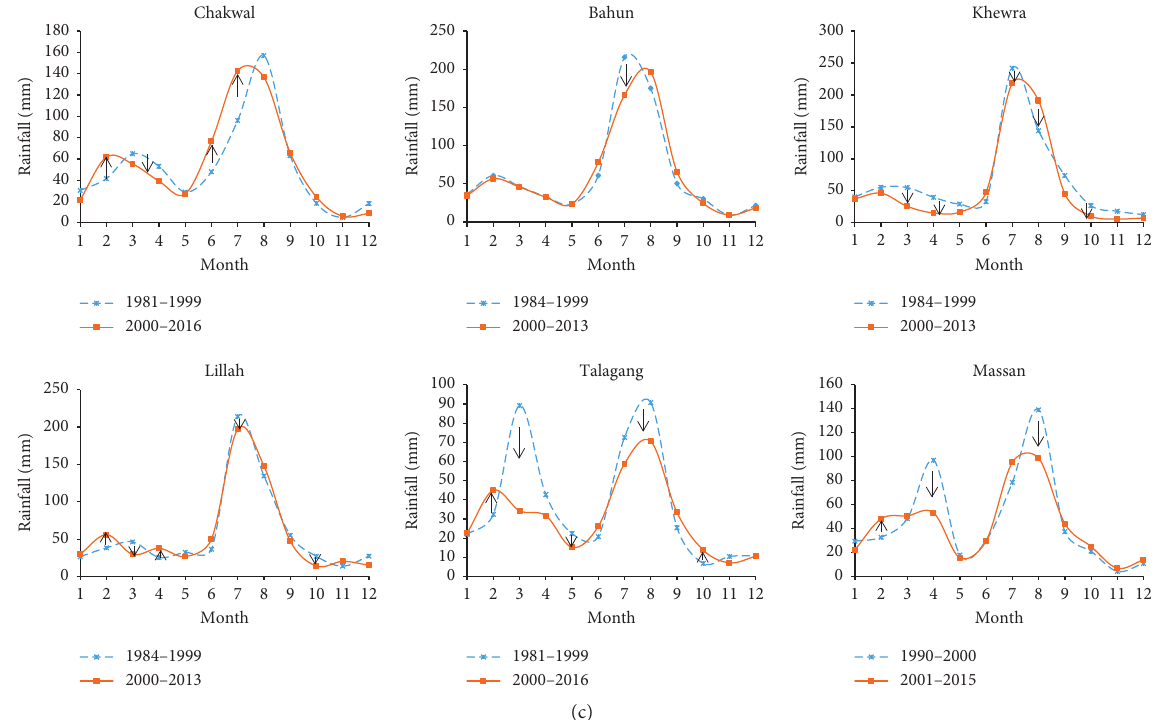
Figure 3: The shifting patterns of mean monthly rainfall distribution in (a) zone-1 (Murree, Kotli Sattian, Islamabad, Rawalpindi, and NARC), (b) zone-2 (Kallar Syedan, Gujjar Khan, Fatehjang, Mangla, and Jhelum), and (c) zone-3 (Chakwal, Bahun, Khewra, Lillah, Talagang, and Massan) rainfall